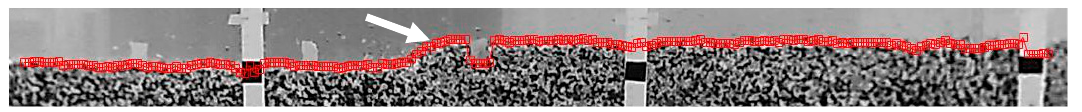
Figure 12. A sample vertical profile of percentage of white pixels in a search area (white circles) and the profile reaches based on slope values (gray dashed line).